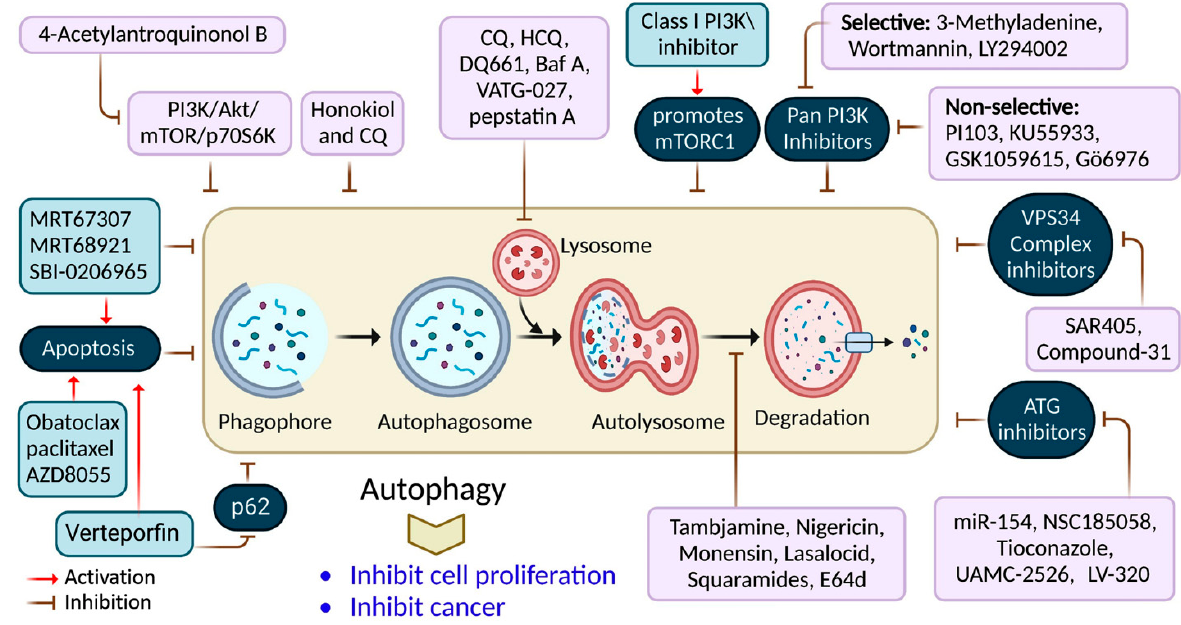
Figure 4. Autophagy inhibition by several compounds and drugs used in cancer therapy. Autophagy’s late phase involves autophagosomes fusing with lysosomes, which con- tain hydrolases that destroy the autophagosomes’ contents. During this stage, autophagy is suppressed by the lysosomal blockers, bafilomycin A1 (Baf-A1), chloroquine (CQ), and its derivatives Lys05 and hydroxychloroquine (HCQ), which are antimalarial medicines used for treating malaria and, more recently, cancer